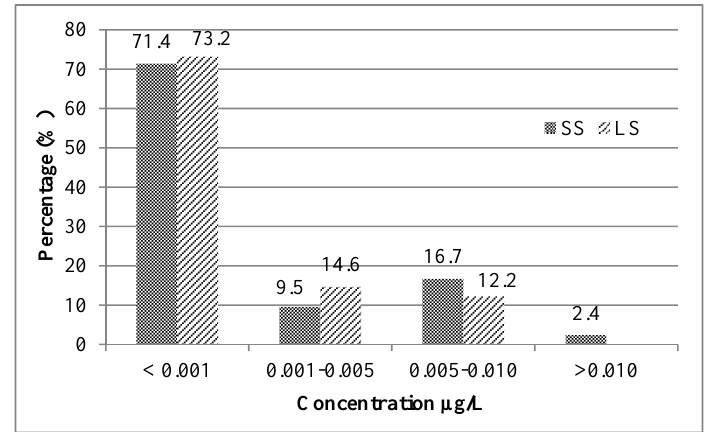
Figure 3. Relative frequency distribution (%) of sterigmatocystin in small- (SS, n = 42) and large-scale (LS, n = 41) brewed beer.